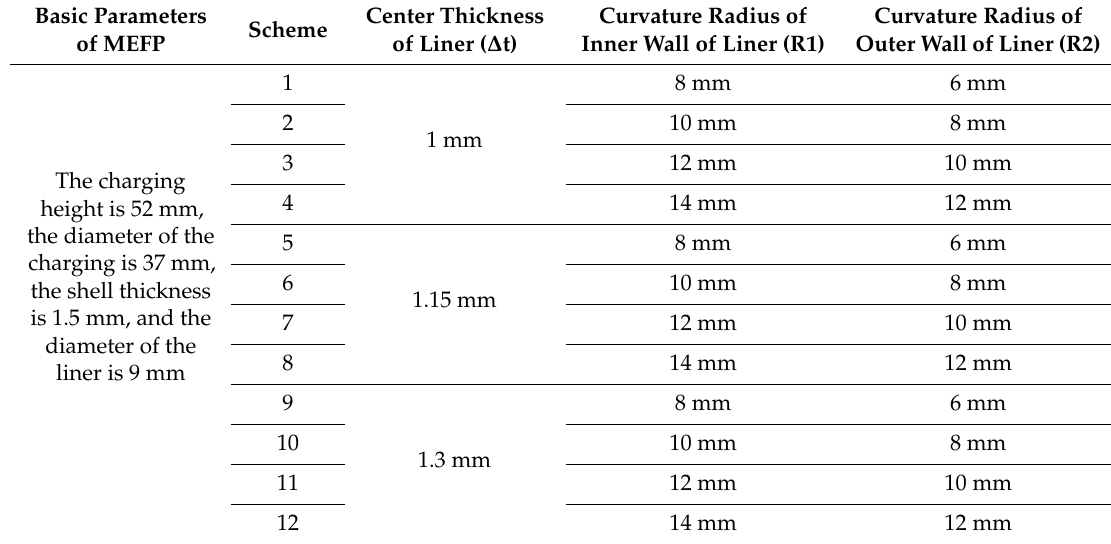
Table 1. Structural parameter design of integral circumferential MEFP.